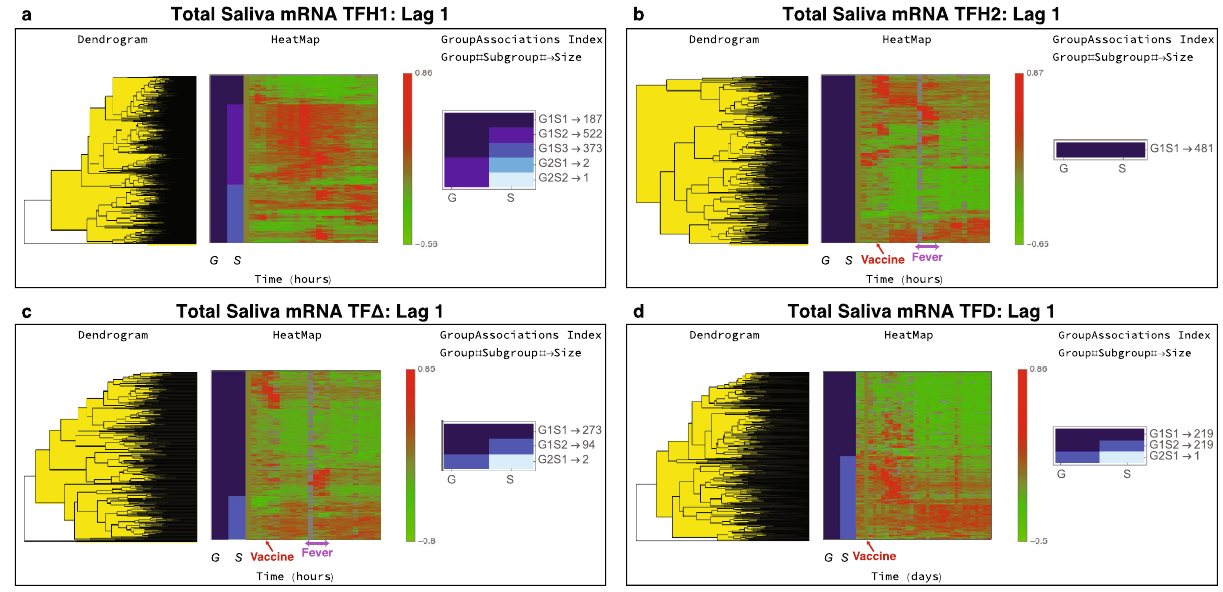
Figure 5. Total saliva mRNA time series trends. The Lag 1 classification results from MathIOmica are shown for the different time frames. ( a ) During TFH1 the subject followed their normal routine. ( b ) During TFH2, the subject was vaccinated with PPSV23. For both TFH1 and TFH2 the first timepoint corresponds to 7 am. Vaccination took place at 10.30 am. The subject reported fever from 5.30 to 10 pm. ( c ) The TF (cid:31) results correspond to paired differences between TFH2 and TF1 hourly points, to remove intra-day variation so as to focus on the perturbation vaccination responses. The plot is indicative of a response to the vaccine and a response that coincides with the reported fever. ( d ) For the daily data, TFD, the corresponding vaccine timepoint is Day 3. There is a direct response the days following the vaccination, and a different response in a subset of genes approximately a week following the vaccination, corresponding to immune system